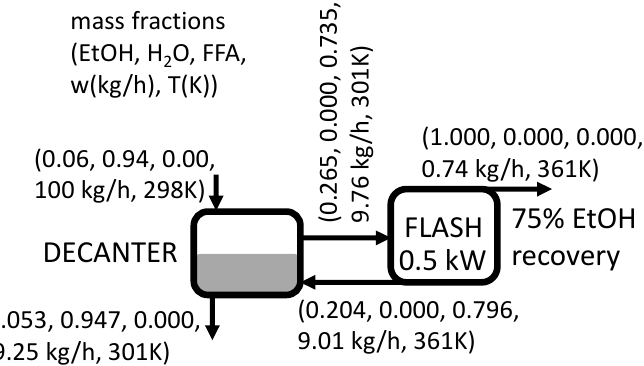
Figure 11. Process scheme when water is not present in the extract.